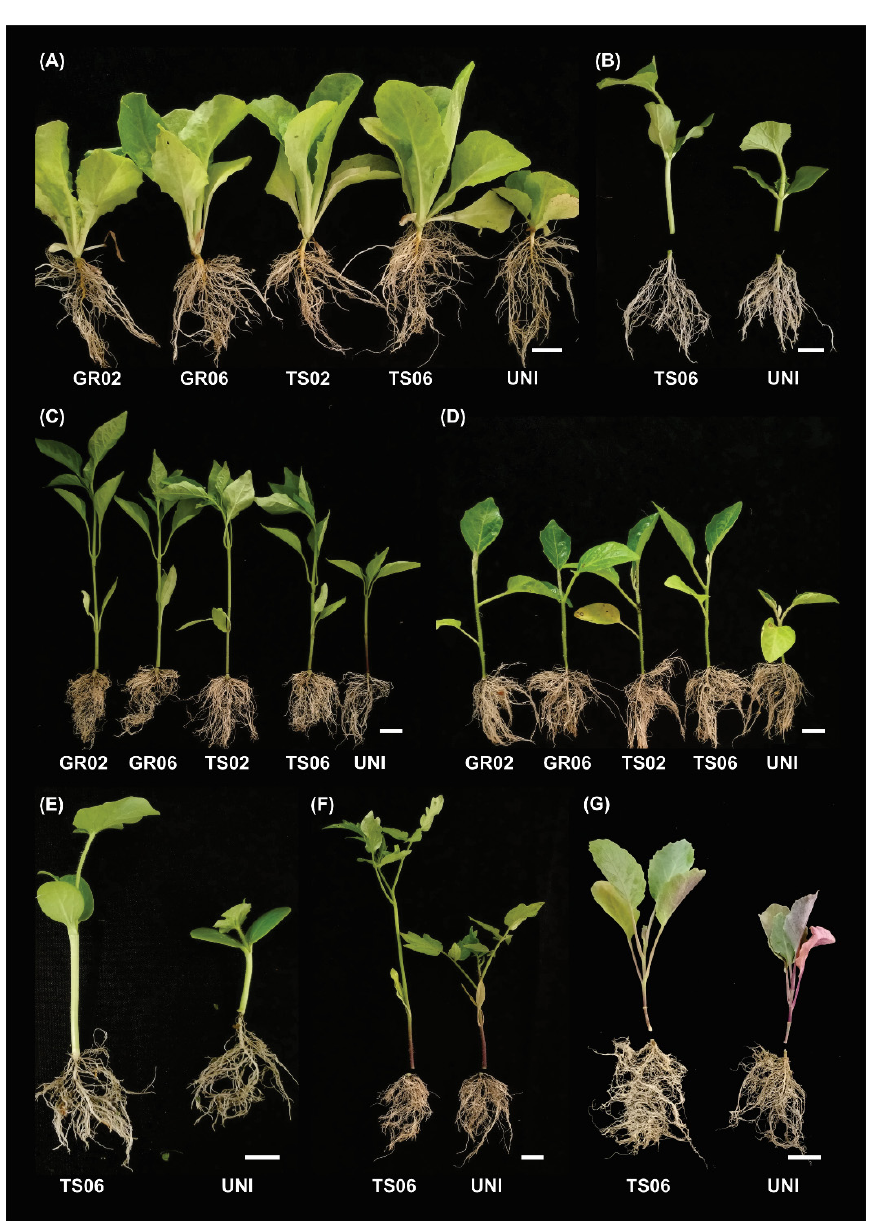
Figure 1. Seedlings of ( A ) lettuce, ( B ) melon, ( C ) pepper, ( D ) scarlet eggplant, (E) watermelon, ( F ) tomato, and ( G ) kale inoculated or not with Aspergillus niger FS1. GR02 and GR06: in-furrow granular application at 10 2 and 10 6 conidia plant − 1 , respectively; TS02 and TS06: seed treatment at 10 2 and 10 6 conidia plant − 1 , respectively; UNI: uninoculated control. Scale bars: 2 cm.